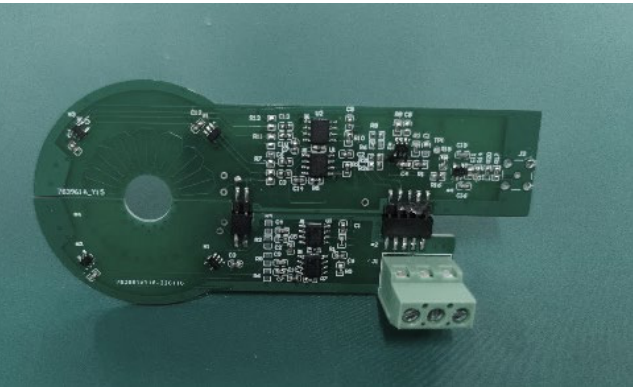
Figure 20. Physical figure of the non-contact composite broadband current sensor.